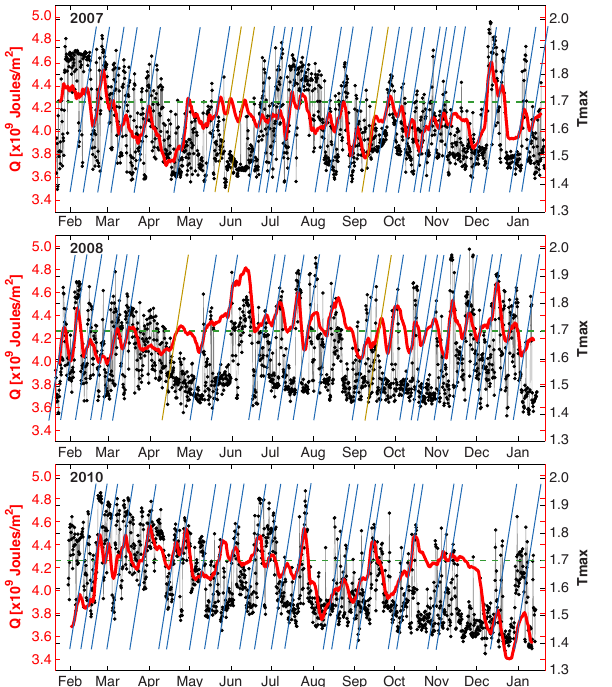
Fig. 4. For the mooring #1, the gravest mode of Q (solid red line) overlaying T max (black line with dots). Nearly every Q -event shows a core T max greater than 1.7 ◦ C (pure UCDW). Blue slanted lines (all of the same slope) show similar dQ/dt for each event. Gold slanted lines (same slope as blue lines) show rare events not co- incident with T max ≥ 1.7 ◦ C.